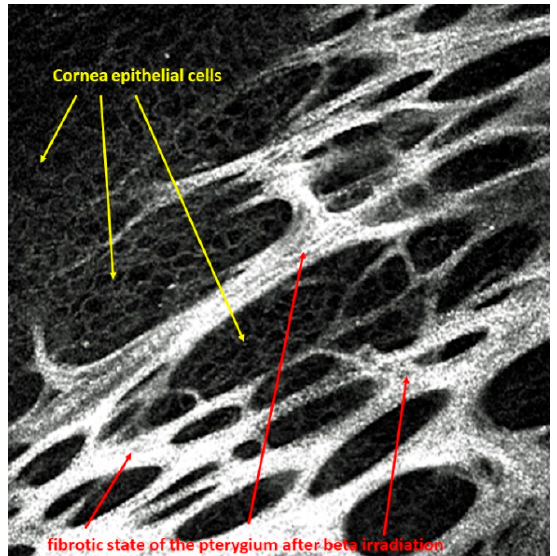
Figure 1. Islets of corneal epithelial cells arranged within the fibrous structures of the pterygium after beta irradiation.